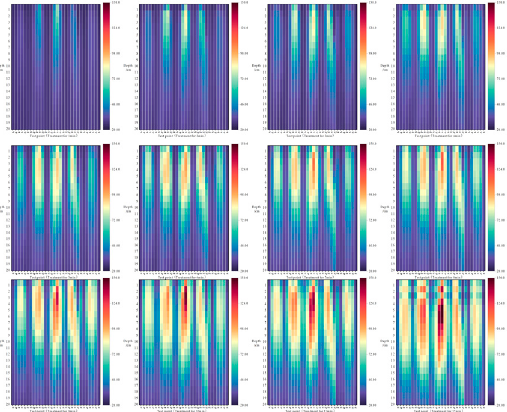
Figure 16. Heatmap of the internal temperature of 10% loess under microwave irradiation.